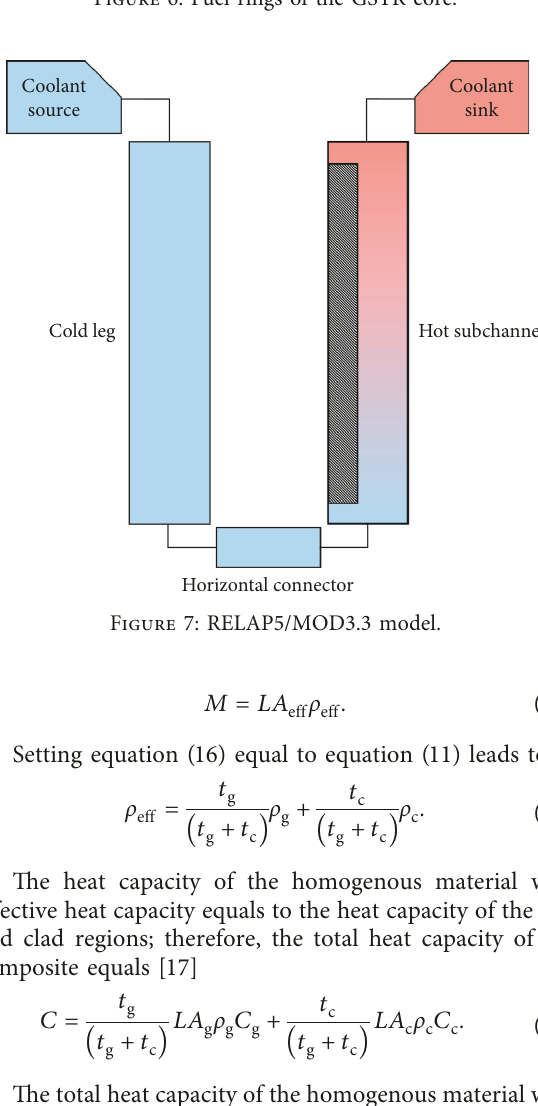
Figure 6: Fuel rings of the GSTR core.